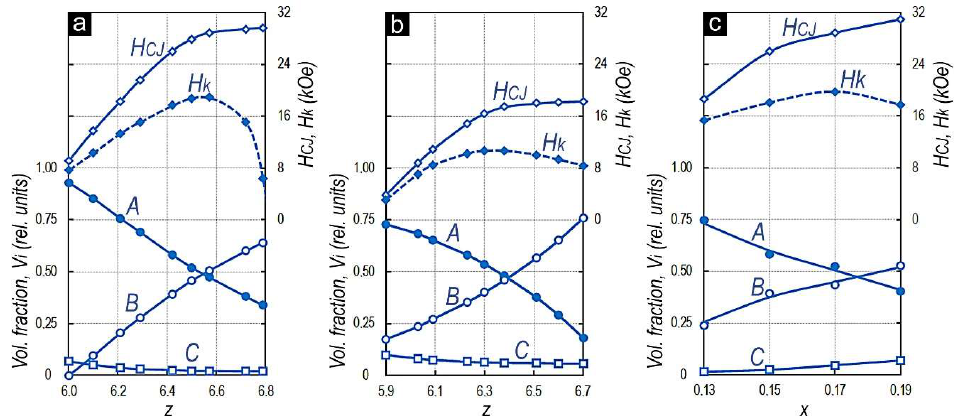
Figure 2. Diagrams plotted on coordinates Z (X) (chemical composition)—volume fractions of structural components A, B and C (Vi)—coercive force (H CJ ), and hysteresis loop squareness parameter (H k ) for the high-coercivity ( a ) Sm 0.85 Zr 0.15 (Co 0.702 Cu 0.088 Fe 0.210 ) z , ( b ) Sm 0.85 Zr 0.15 (Co 0.665 Cu 0.075 Fe 0.260 ) z , and ( c ) Sm 1-x Zr x (Co 0.702 Cu 0.088 Fe 0.210 ) 6.4 samples.